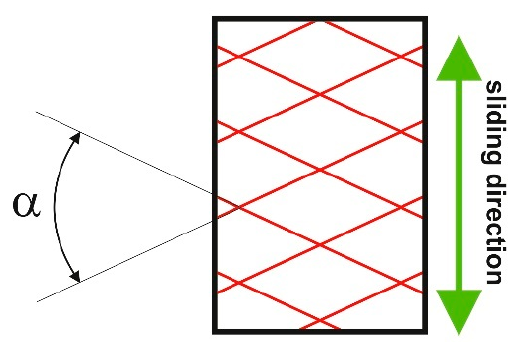
Figure 3. Honing angle α .